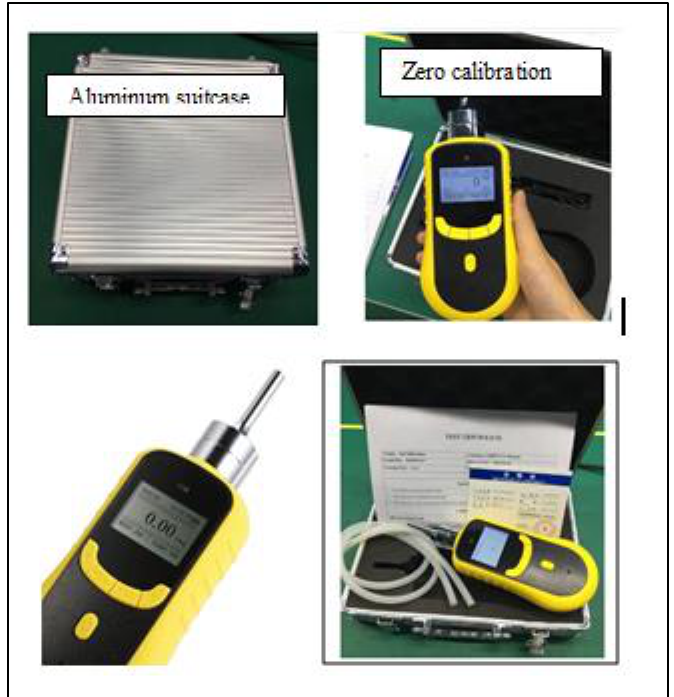
Figure 2. SKY 2000-WH-O 3 meter.